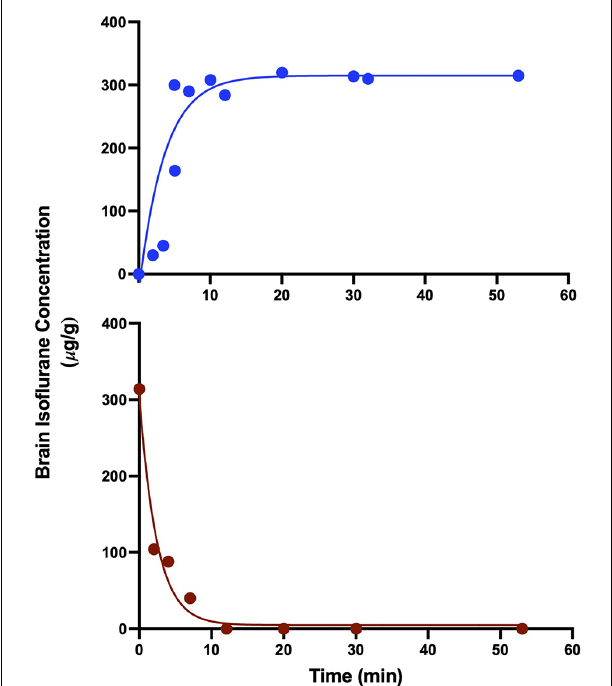
FIGURE 4 | Brain isoflurane concentration reaches steady state in 8–12 min. Mice starting at 100% O 2 and exposed to 0.9% isoflurane (top) reach steady state by 8 min, while mice exposed to 0.9% isoflurane for 30 min, followed by 100% O 2 (bottom) reach undetectable levels of isoflurane in the brain by 12 min after the start of O 2 administration. R 2 values for exponential fits were 0.784 for wash-in and 0.974 for